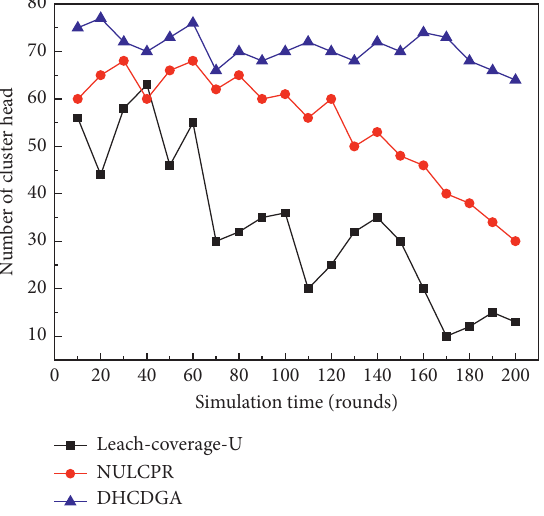
Figure 7: Number of cluster heads.